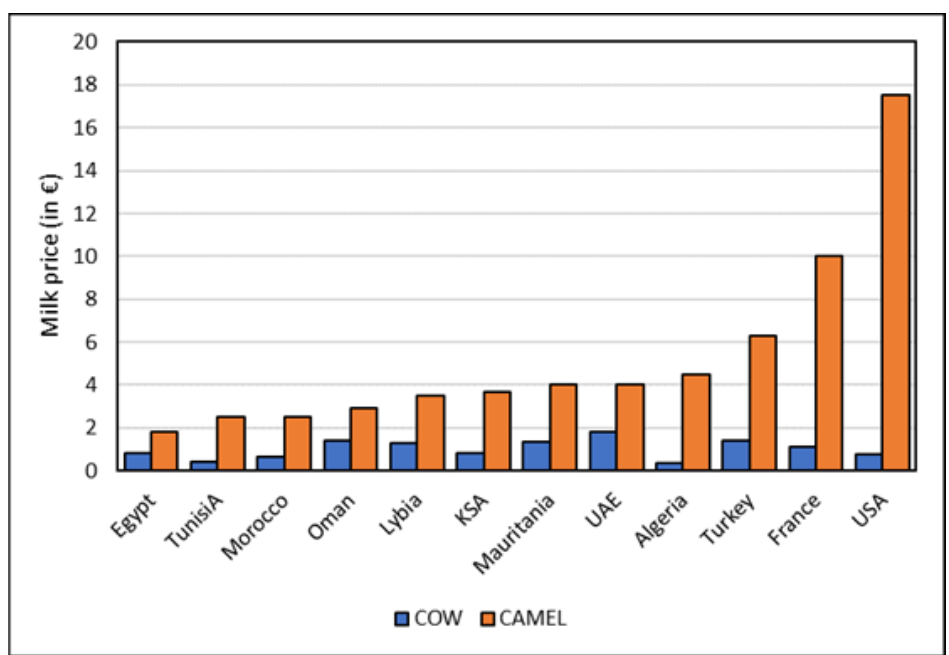
Figure 1. Differential prices of dromedary camel and cow milk in different countries.